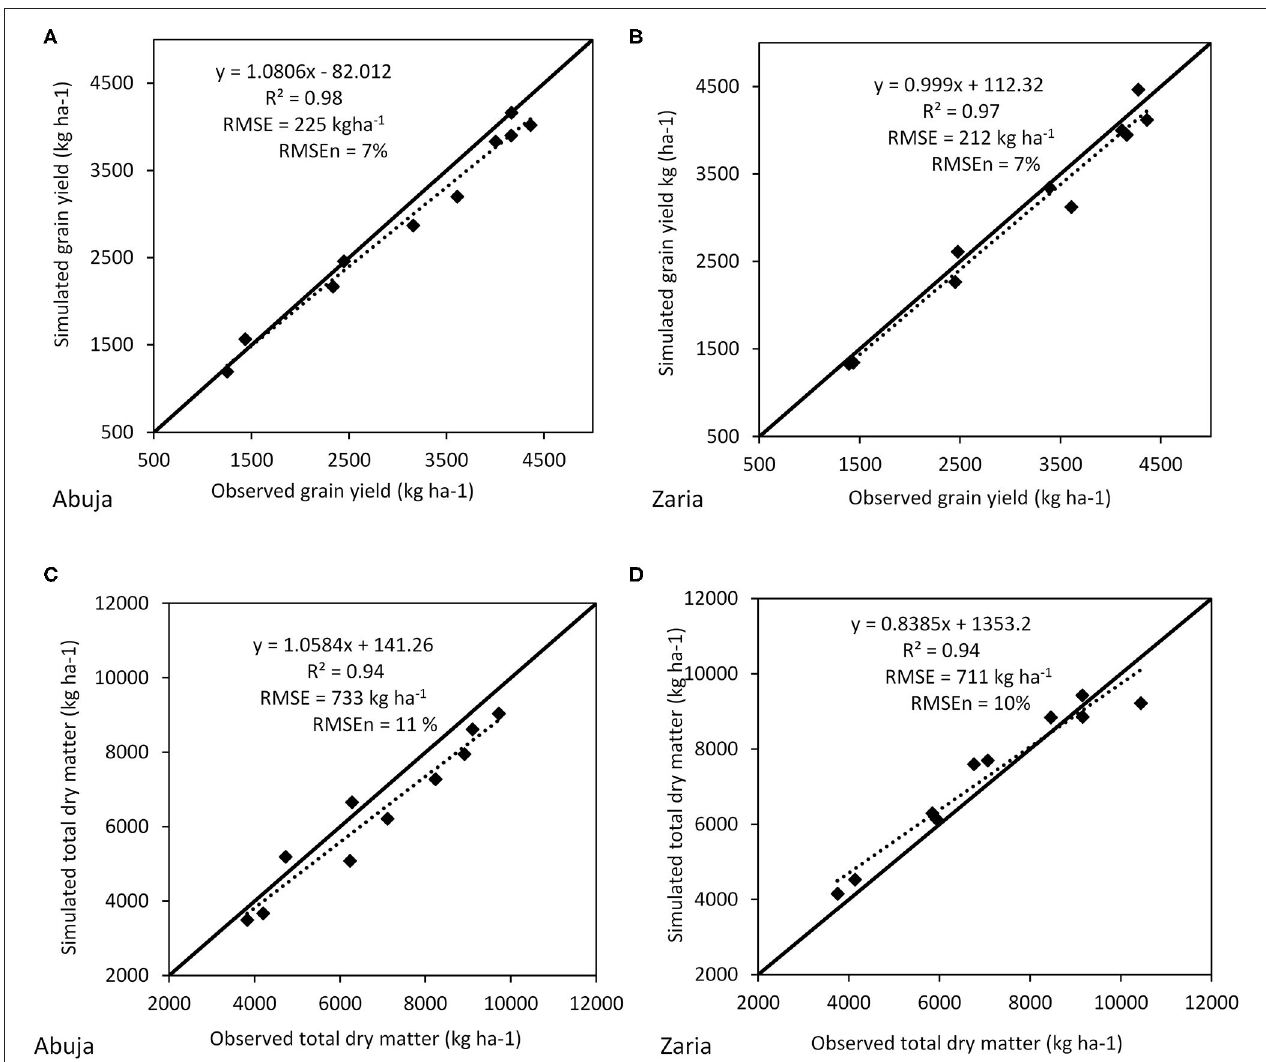
FIGURE 2 | (A–D) Comparison of observed and simulated outputs of model validation data for grain yield and total dry matter (TDM) at varying N-fertilizer applications for 2009EVDT in Abuja and Zaria (each point is average of treatment during 2016 and 2017 cropping